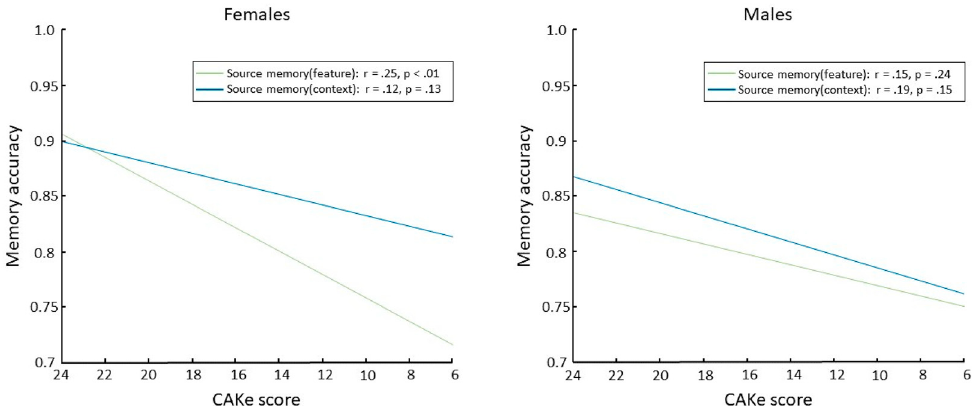
Figure 1. Source memory accuracies as a function of CAKE scores for females (left) and males (right; correlation values and p -values at the upper right of each panel). Reprinted from Brain and Cognition , 166, Haley A. Fritch, Lauren R. Moo, Madeline A. Sullivan, Preston P. Thakral, and Scott D. Slotnick, “Impaired Cognitive Performance in Older Adults is Associated with Deficits in Item Memory and Memory for Object Features”, 105957, copyright (2023), with permission from Elsevier.